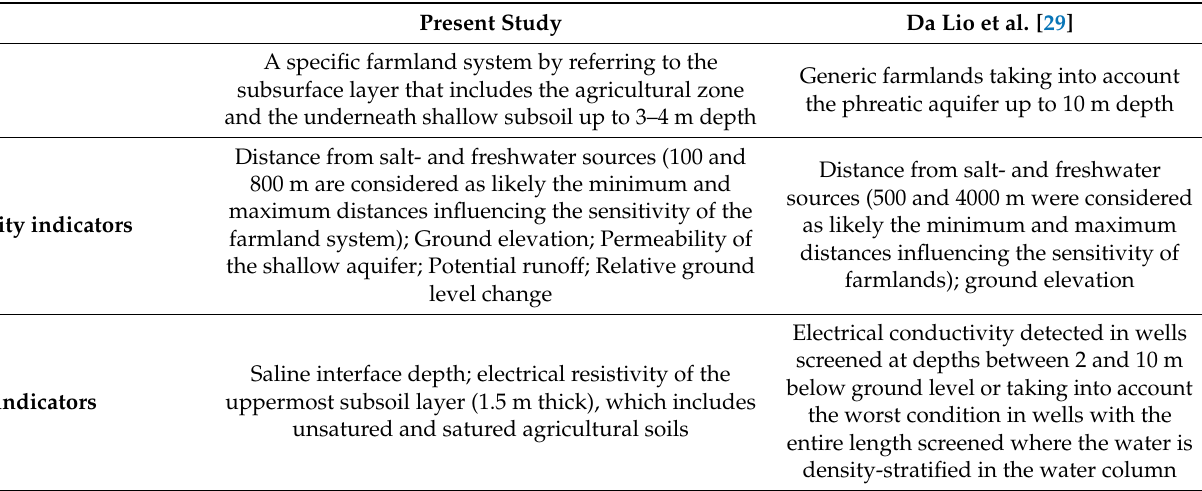
Table 5. Summary of the target and sensitivity/hazard status indicators used in this study and by Da Lio et al. [29] for the vulnerability assessment.